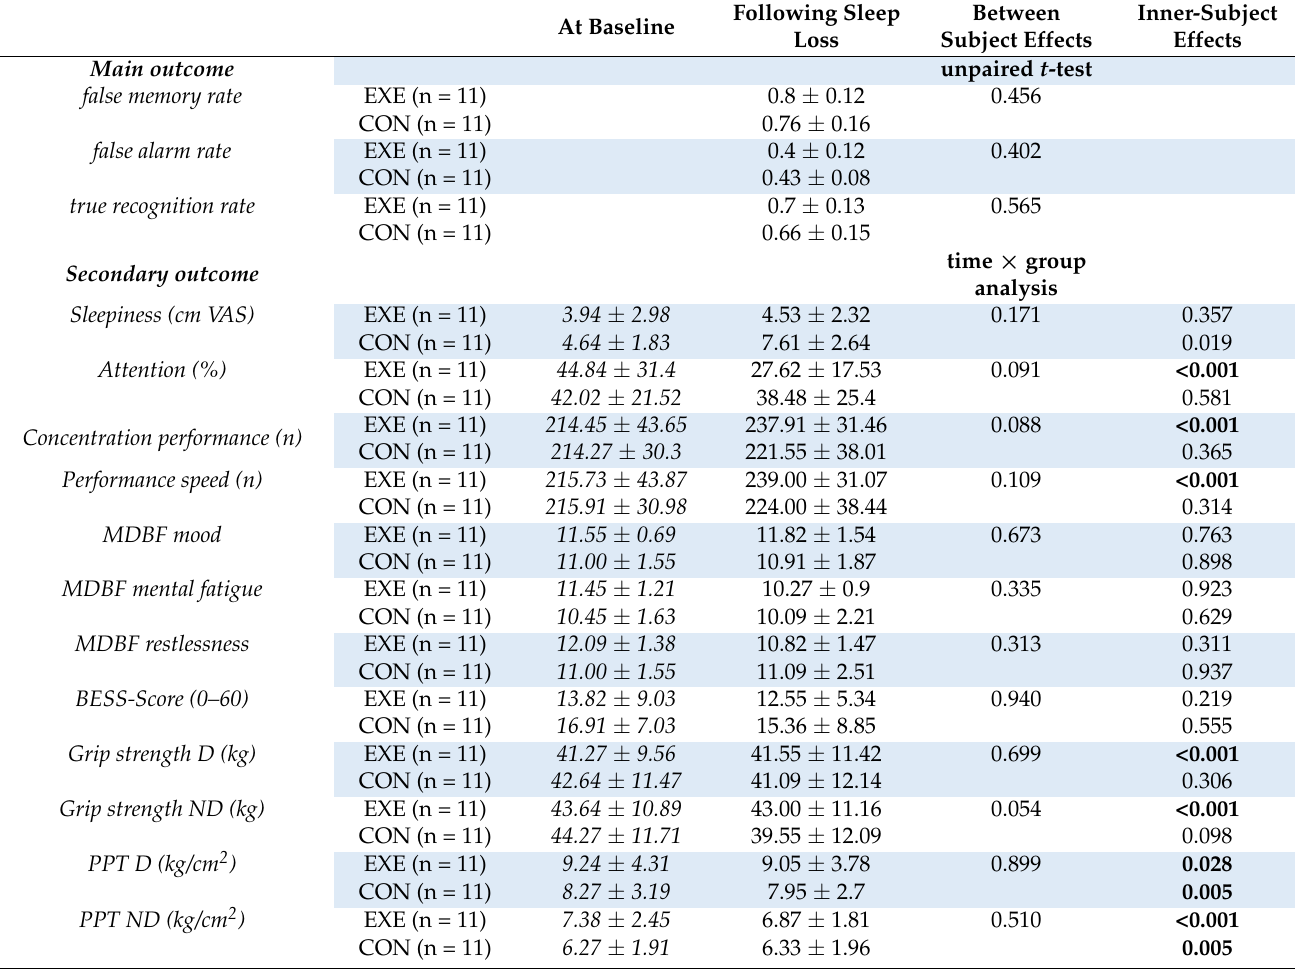
Table 2. Outcome Measures. The table depicts all outcome measures between the exercise interven- tion group (EXE) and the control group (CON) at baseline and following one night of sleep loss. The main outcome measure was assessed only once, following sleep loss, applying an unpaired t -test between groups. All other statistics was performed as time × group (2 × 2) analysis. Inner-subject effects are displayed calculating paired t test within the groups. VAS, visual analogue scale; MDBF, multidimensional mood questionnaire; BESS, balance error scoring system; D, dominant side; ND, non-dominant side; PPT, pressure pain